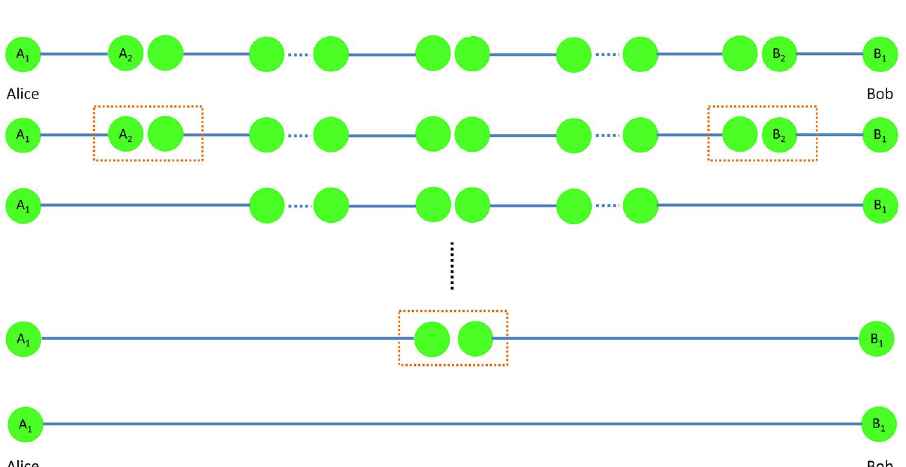
Figure 2. Extending the entanglement swapping procedure in Fig. 1 to long distances with many repeater stations in